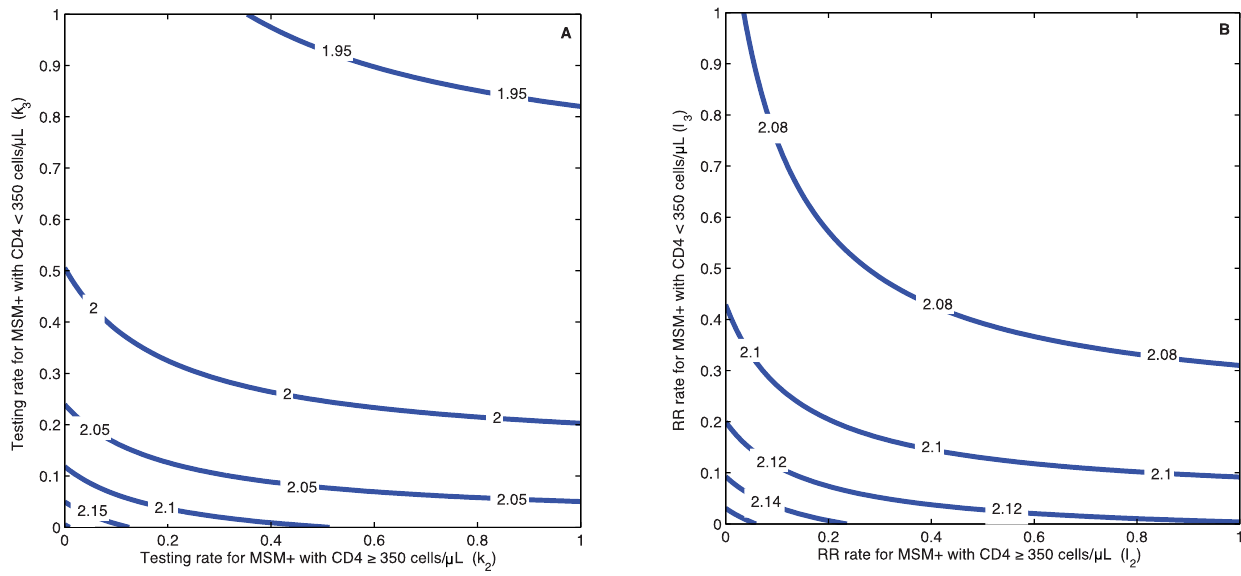
Figure 3. Contour plots: the effects on R 0 under different coverage rates of HIV testing and risk reduction interventions among HIV-infected Chinese MSM while condom use remains at the average level of years 2000–2010. (A) Under the different coverage rates of HIV testing intervention; (B) Under the different coverage rates of HIV risk reduction (RR) intervention.